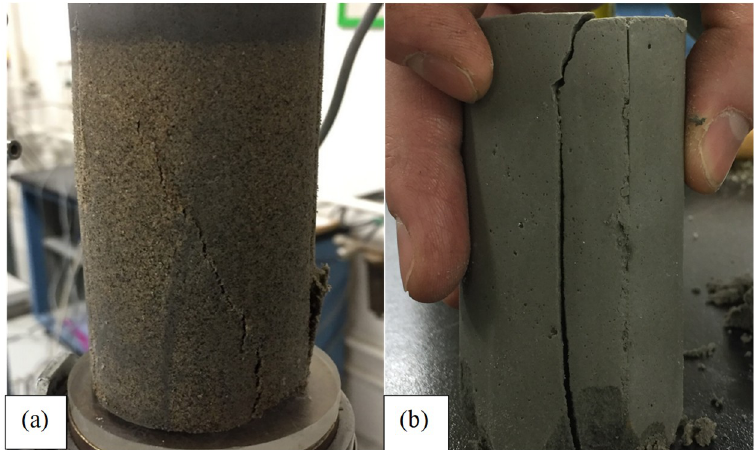
Figure 10. Typical failure modes of cylindrical cemented hydraulic fill (CHF) samples under uniaxial compression: ( a ) diagonal shear, ( b ) vertical split (or columnar split).